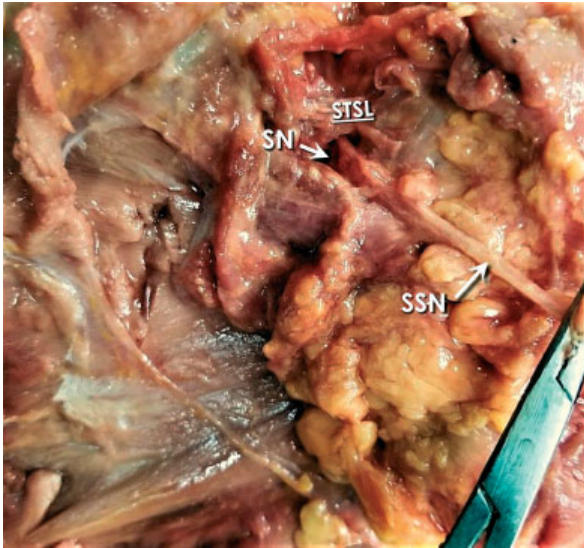
Fig. 2 Type-I content of the SN according to the classi fi cation used (normal anatomy). SN, suprascapular notch; SSN, suprascapular nerve; SSV, suprascapular vein; STSL, superior transverse scapular ligament.